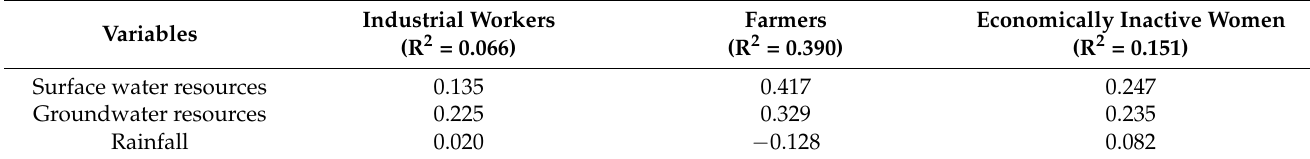
Table 7. Significant predictors of resource component.